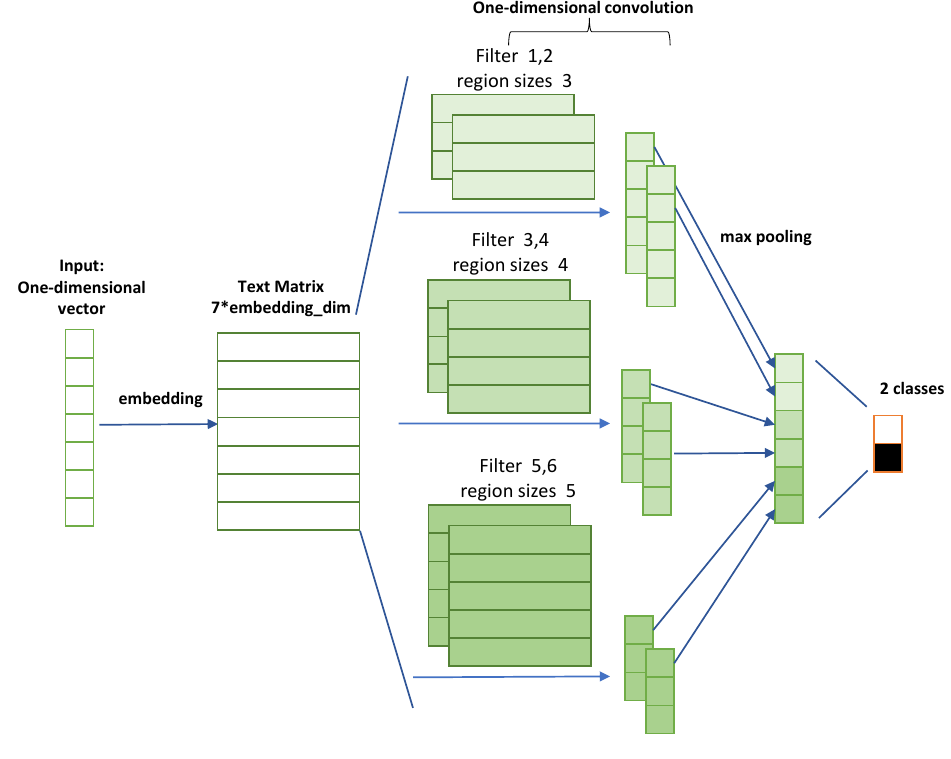
Figure 1. Architecture of the TextCNN [7].